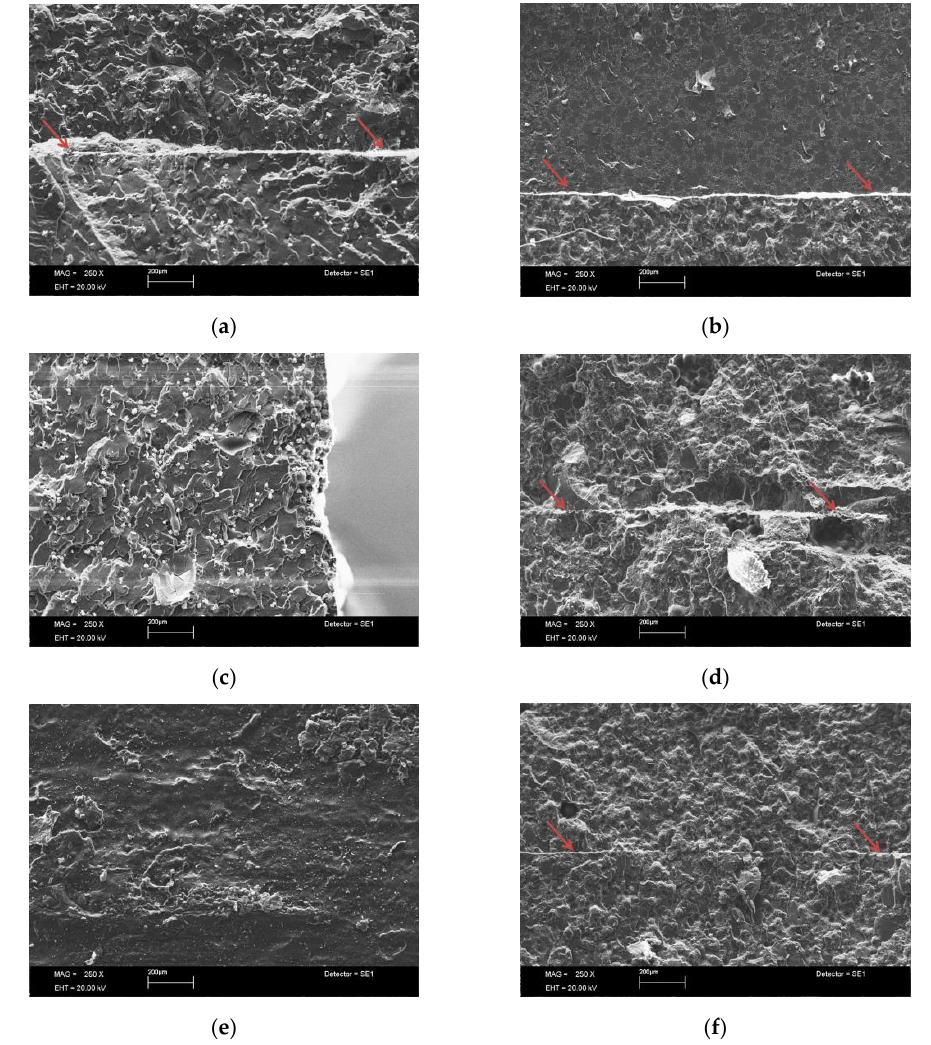
Figure 4. Images of the fractured surface with the scanning electron microscope (SEM); Palacos R+G revision at 4W + 1d ( a ), 4W + 3d ( c ), and 4W + 10d ( e ); ( b ) SmartSet MV revision at 4W + 1d ( b ), 4W + 3d ( d ), and 4W + 10d ( f ), red arrows show the line between the two layers.